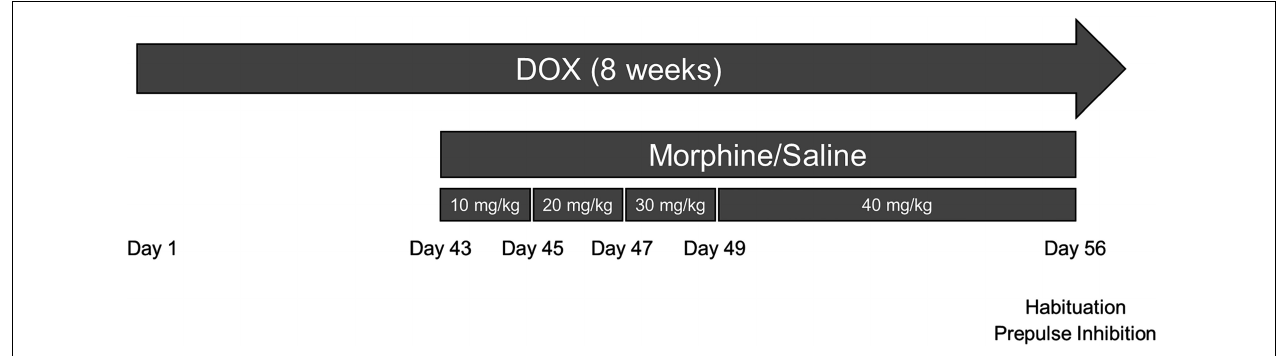
FIGURE 1 | Experimental design depicted on a timeline. Tat transgenic mice received doxycycline (DOX)-containing chow for 8 weeks (the entire experimental length) and were repeatedly injected with morphine (10–40 mg/kg, increasing by 10 mg/kg/2 day, s.c., b.i.d.) or saline for the last 2 weeks of DOX administration. On day 56 (day 14 of repeated morphine injections), mice were tested for the acoustic startle response, habituation to the startle tone, and prepulse inhibition (PPI) of the response. On day 57, the day following behavioral testing, mice were euthanized, and tissues were randomly assigned to immunoblotting or Golgi